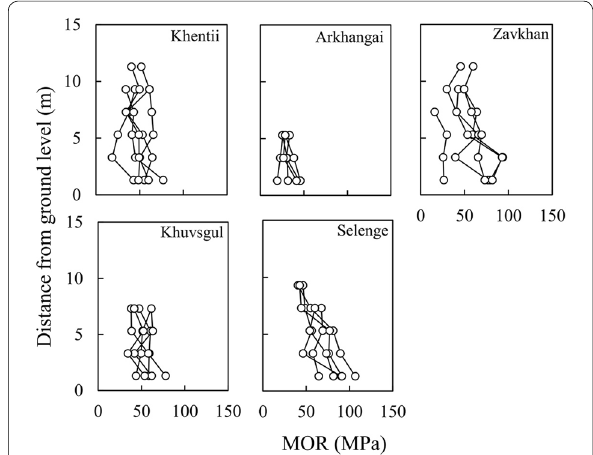
Fig. 2 Longitudinal variations of modulus of rupture (MOR) of lumber in each provenance. Open circles indicate mean values of MOR of lumber obtained from each height. n number of lumber